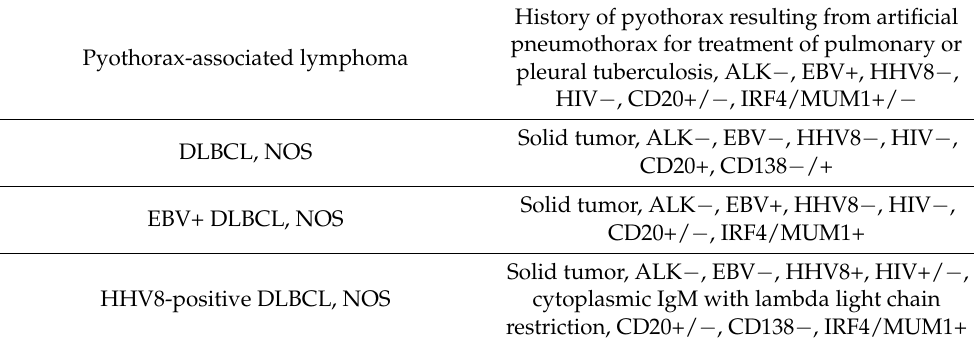
Table 5. Differential diagnoses of PEL with a B-cell